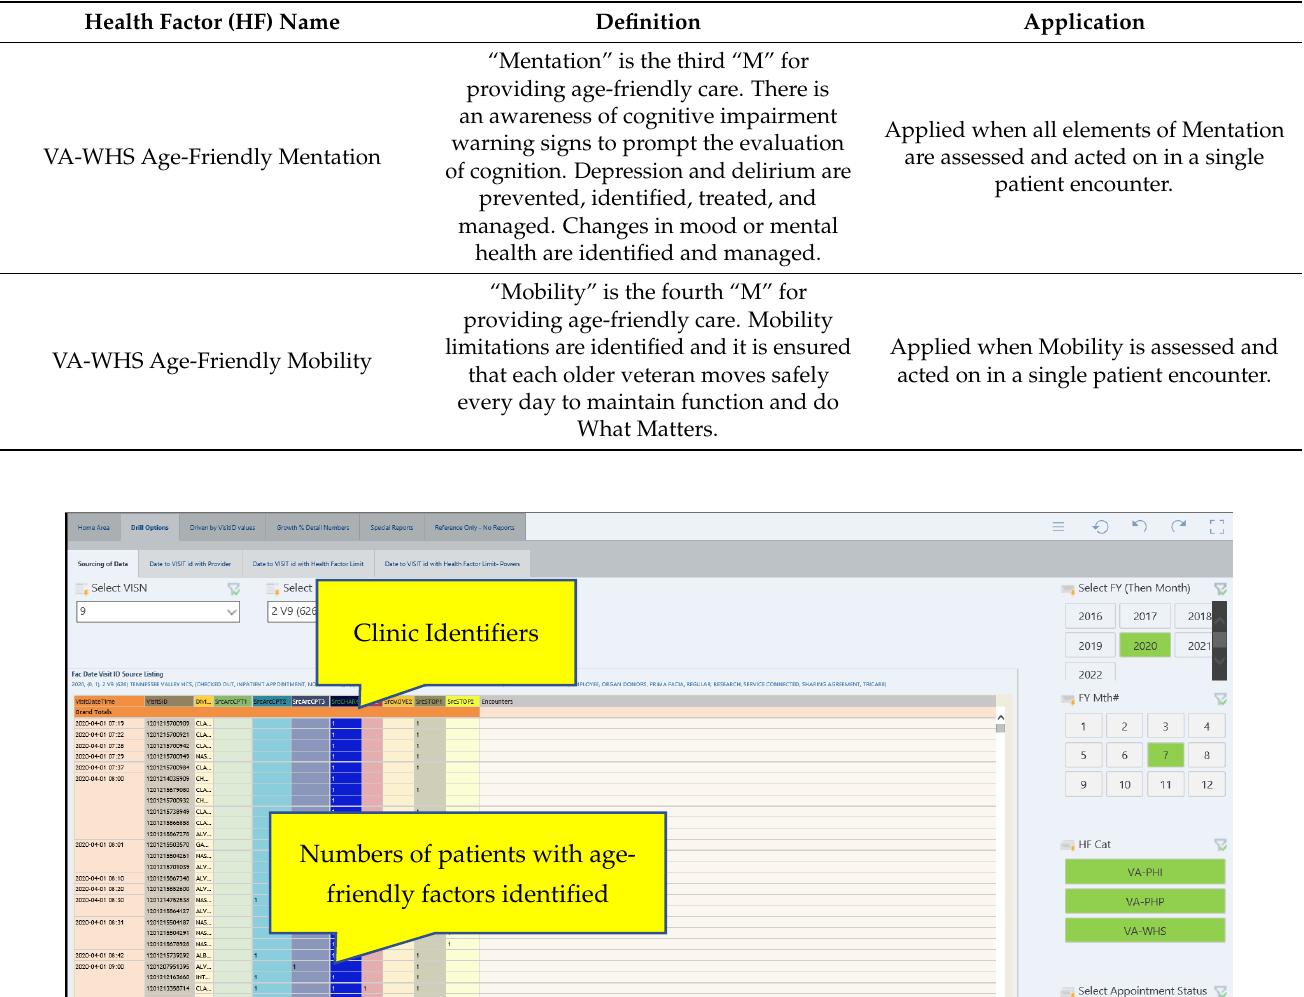
Table 1. Age-friendly whole health